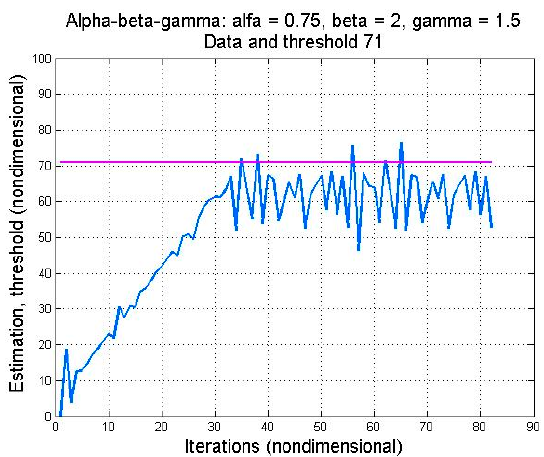
Figure 18. With modified parameter values, the α – β – γ filter provides estimations that exceed the threshold of